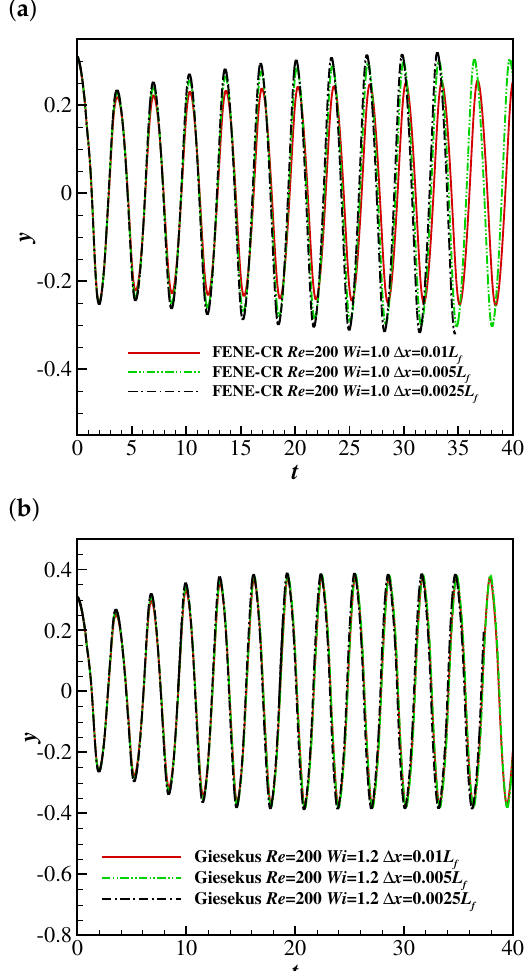
Figure 5. The time histories of the free-end position of the filament at Re = 200 and Wi = 1.0 in the ( a ) FENE-CR and ( b ) Giesekus fluids at different values of Pr